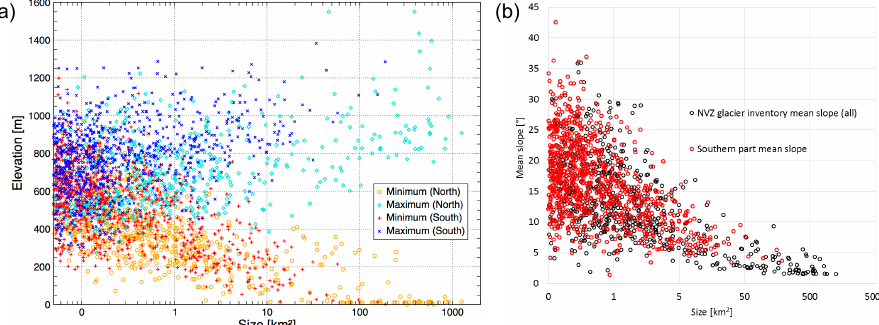
Figure 8. ( a ) Maximum and minimum elevation vs. glacier size for the whole island and the southern part only; ( b ) mean slope vs glacier size for the whole island and the southern part only.